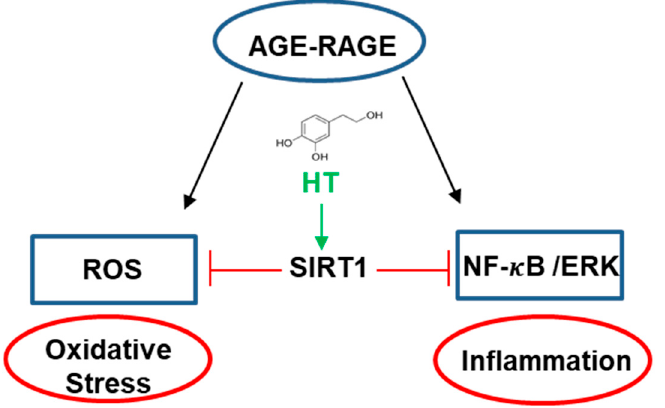
Figure 9. Working hypothesis on the protection effect of HT in AGE cytotoxicity. HT inhibits oxidative stress and inflammation response through the upregulation of SIRT1 expression.